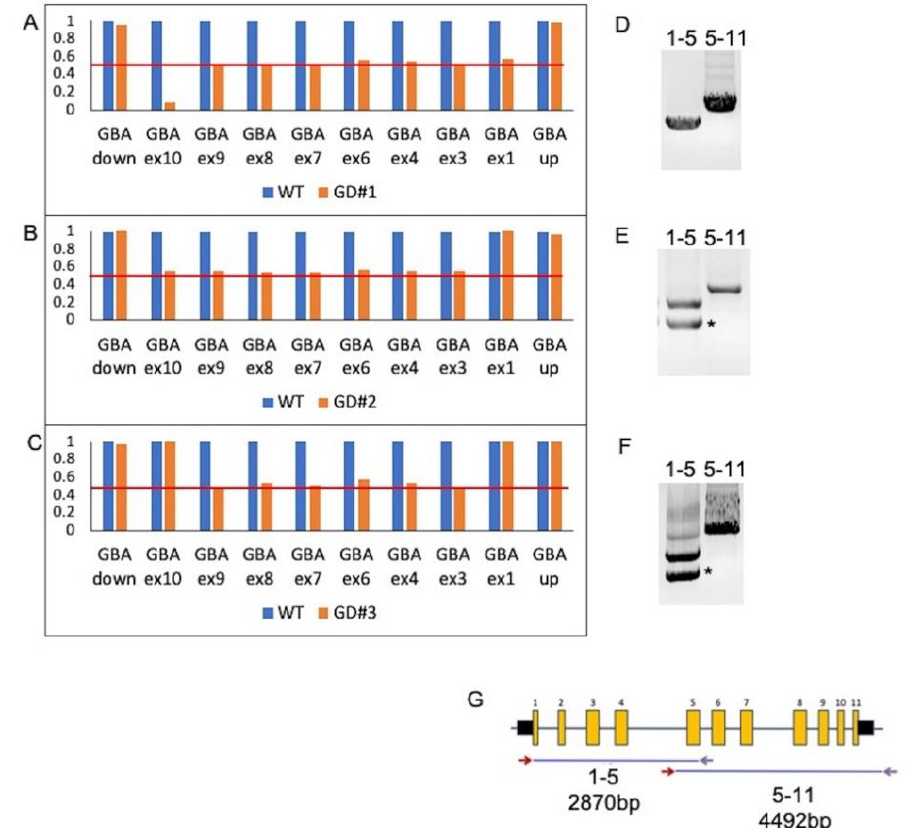
Figure 1. MLPA analysis conducted on GD#1, GD#2, and GD#3 patients. ( A – C ) Normalized bar charts of GBA gene copy number patterns in GD patients (orange bars) and healthy control (blue bars). Data were normalized to those of healthy controls. ( D – F ) PCR amplicons of exon 1 to 5 and of exon 5 to 3 (cid:48) untranslated region of GBA gene of patients GD#1 ( D ), GD#2 ( E ), and GD#3 ( F ). ( G ) Schematic representation of GBA long-range PCR amplicons. Exonic and intronic structures of the GBA gene are indicated by yellow boxes and grey lines, respectively. A forward primer (red arrow) specific to the GBA gene and an unspecific reverse primer (purple arrow) were used to selectively amplify the GBA gene and to avoid pseudogene contamination. * PCR amplification of recombinant allele. Co-segregation analysis of the recombinant allele was extended to GD#3 parents via MLPA assay, showing that it had a maternal